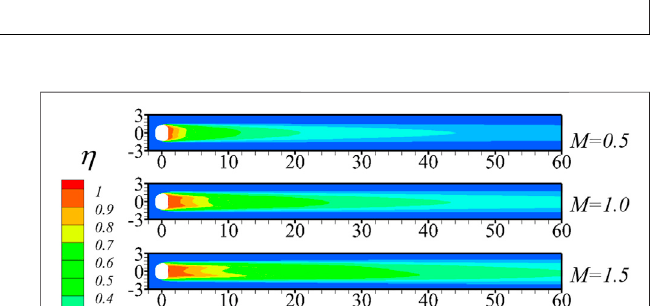
FIGURE 3 | Overall averaged ef fi ciency. (A) Hole length ratio and (B) M.